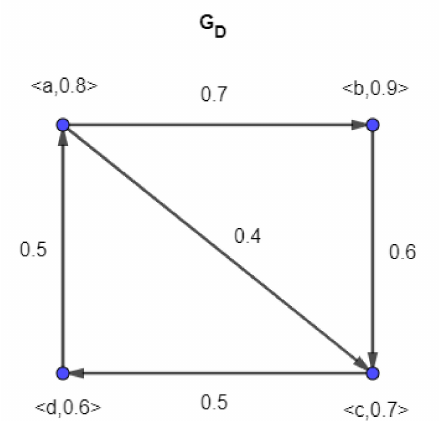
Figure 5. The dominating set of G ∗